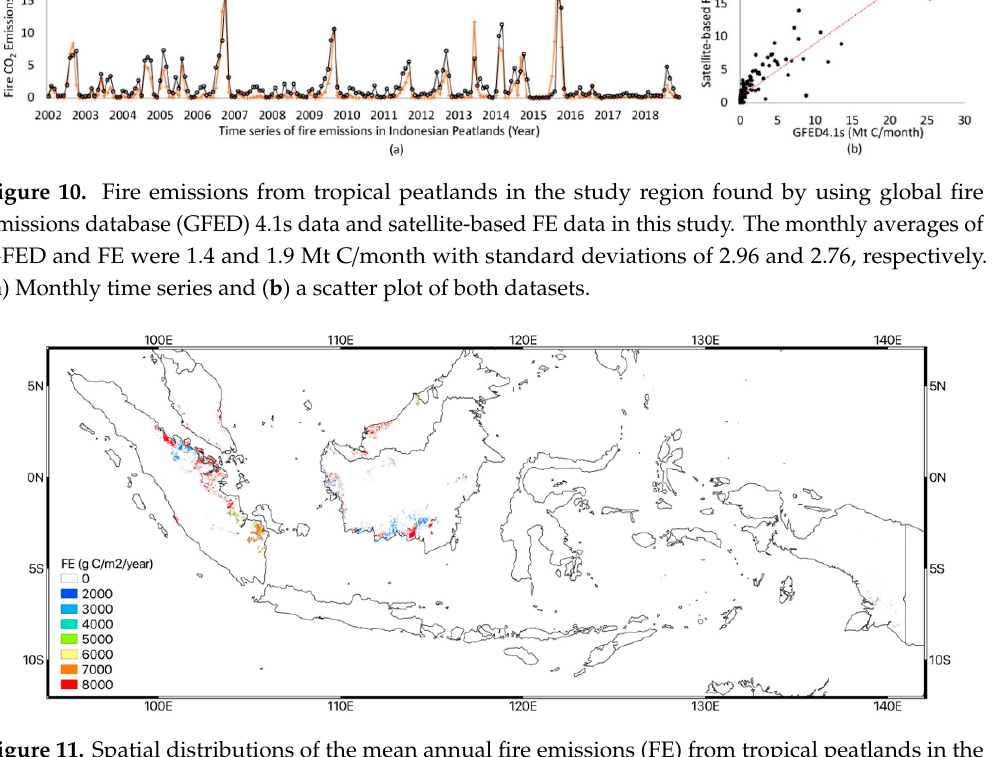
Figure 11. Spatial distributions of the mean annual fire emissions (FE) from tropical peatlands in the study area from 2002 to 2018.